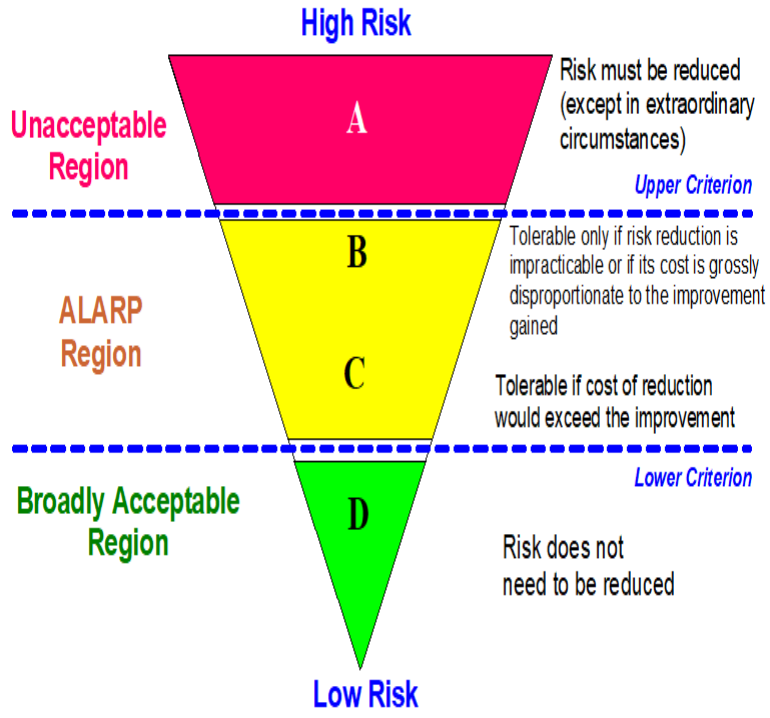
Figure 2. The framework for tolerability of risk, in light of the safety guidelines of HSE (2001) [23].